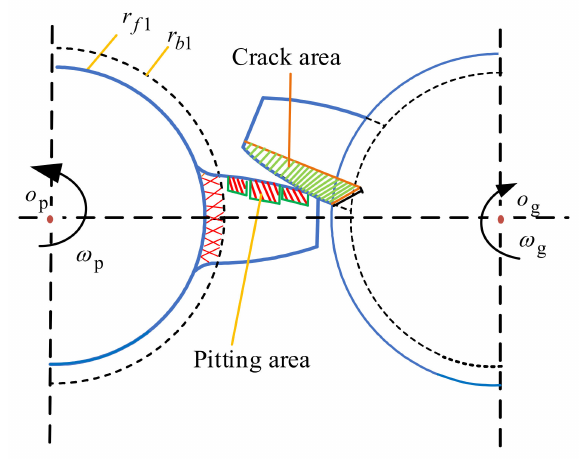
Figure 9. Composite failure model.